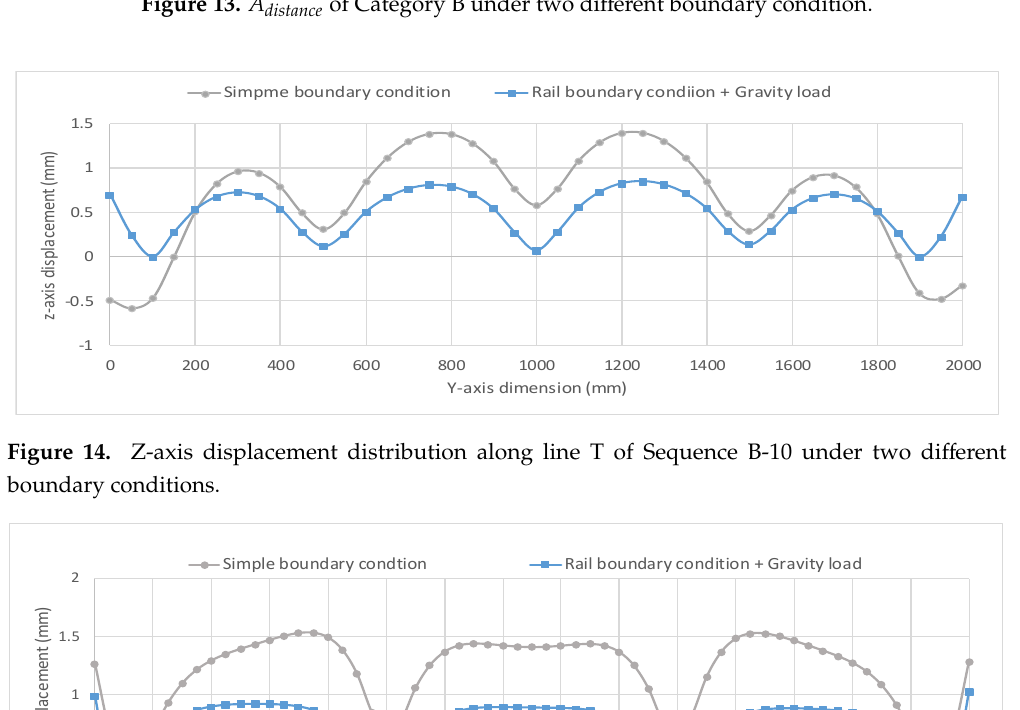
Figure 14. Z-axis displacement distribution along line T of Sequence B-10 under two different boundary conditions.